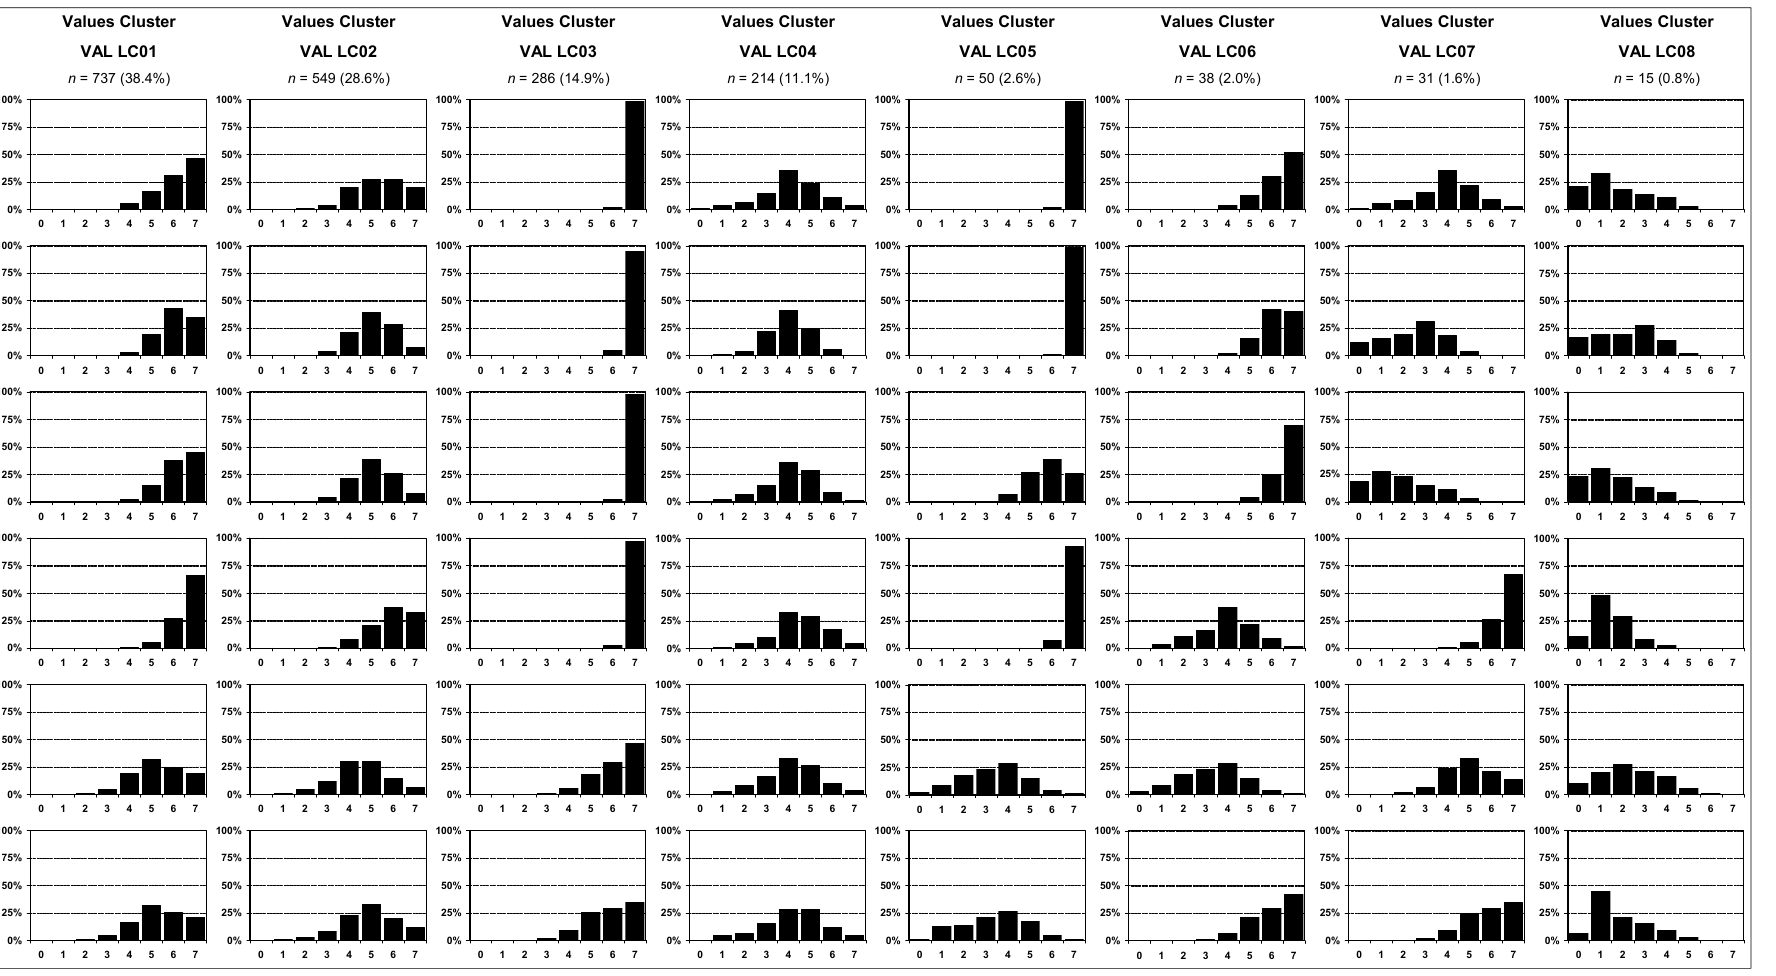
Figure 2. Value-based cluster summary. X-axis labels: 0 = opposed to item as a personal guiding principle; 1 = not at all important to 7 = extremely